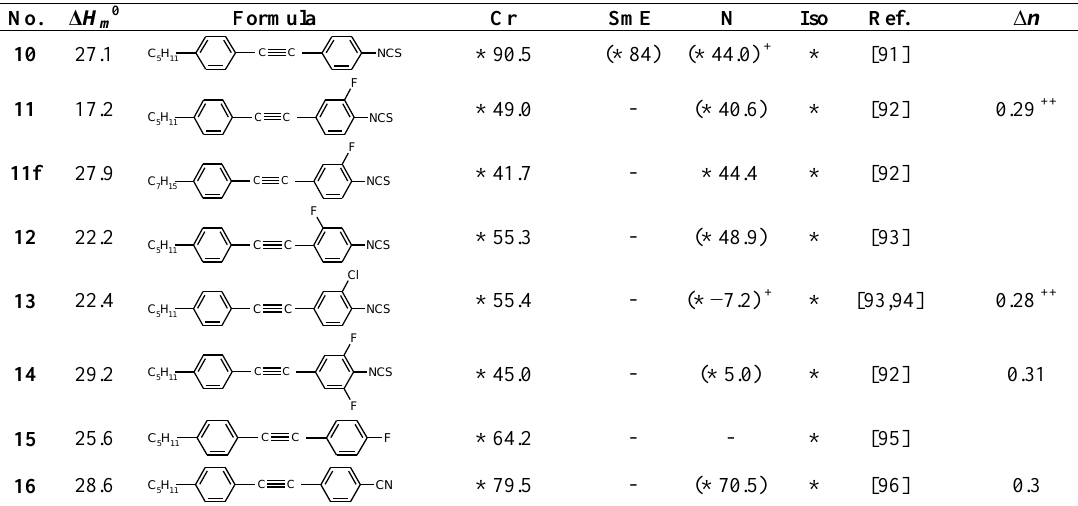
Table 3. Phase transition temperatures [°C], melting enthalpies [kJ/mol] and birefringence of